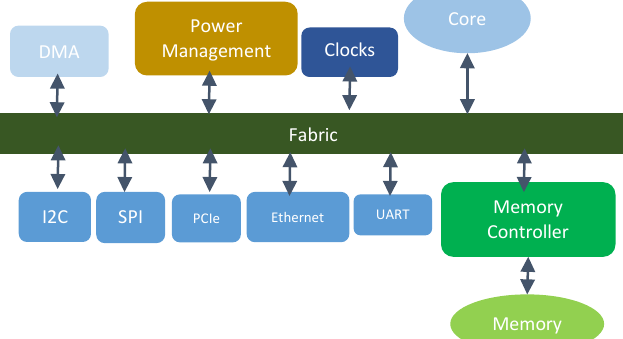
Fig. 1. A typical Microcontroller based Subsystem